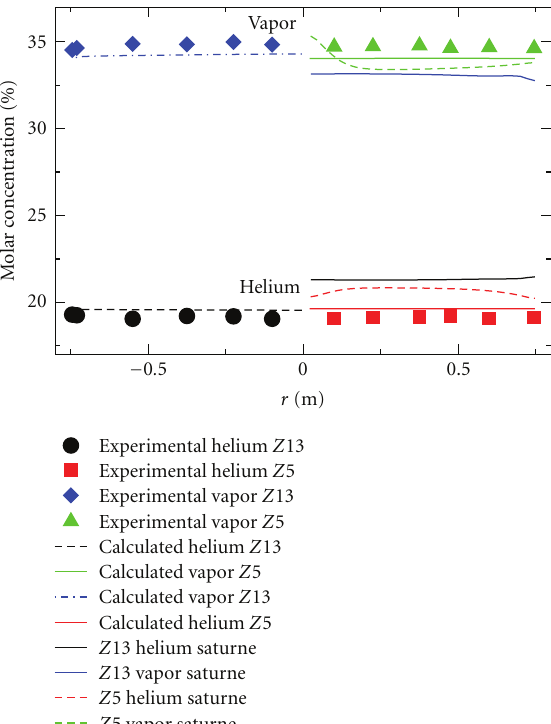
Figure 17: Radial profile of the helium and vapor molar concentra- tion at Z 5 = 1 . 9 m and Z 13 = 3 . 93 m: steady state